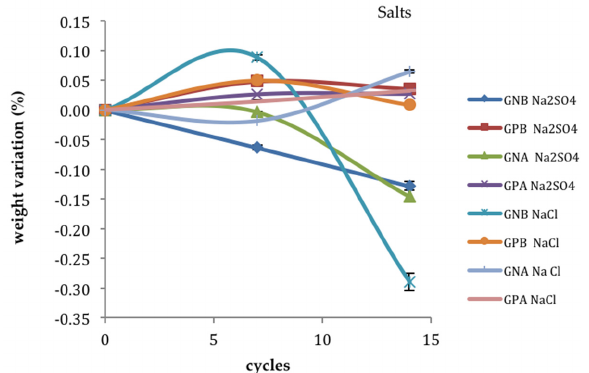
Figure 7. Variations in the weight of the stone samples in the accelerated ageing induced by NaCl and Na 2 SO 4 salt cycles. The sample codes are explained in Table 1.